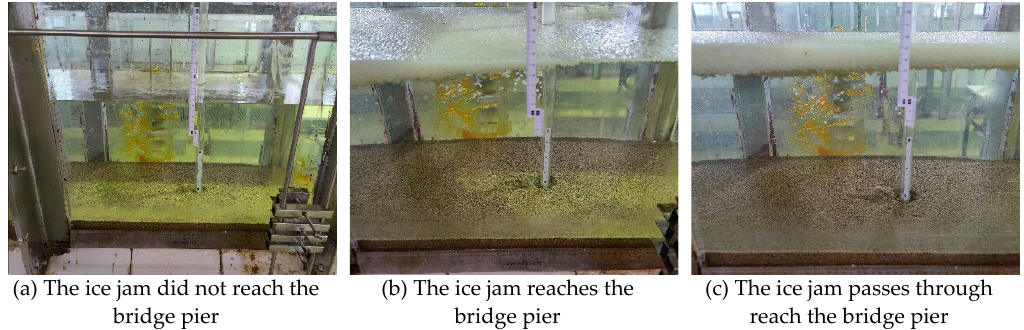
Figure 6. Pier scour for 3 cases: before the head of an initial ice jam reaching the pier ( a ); the head of an initial ice jam reaching the pier ( b ); after the head of an initial ice jam passing the pier ( c ).